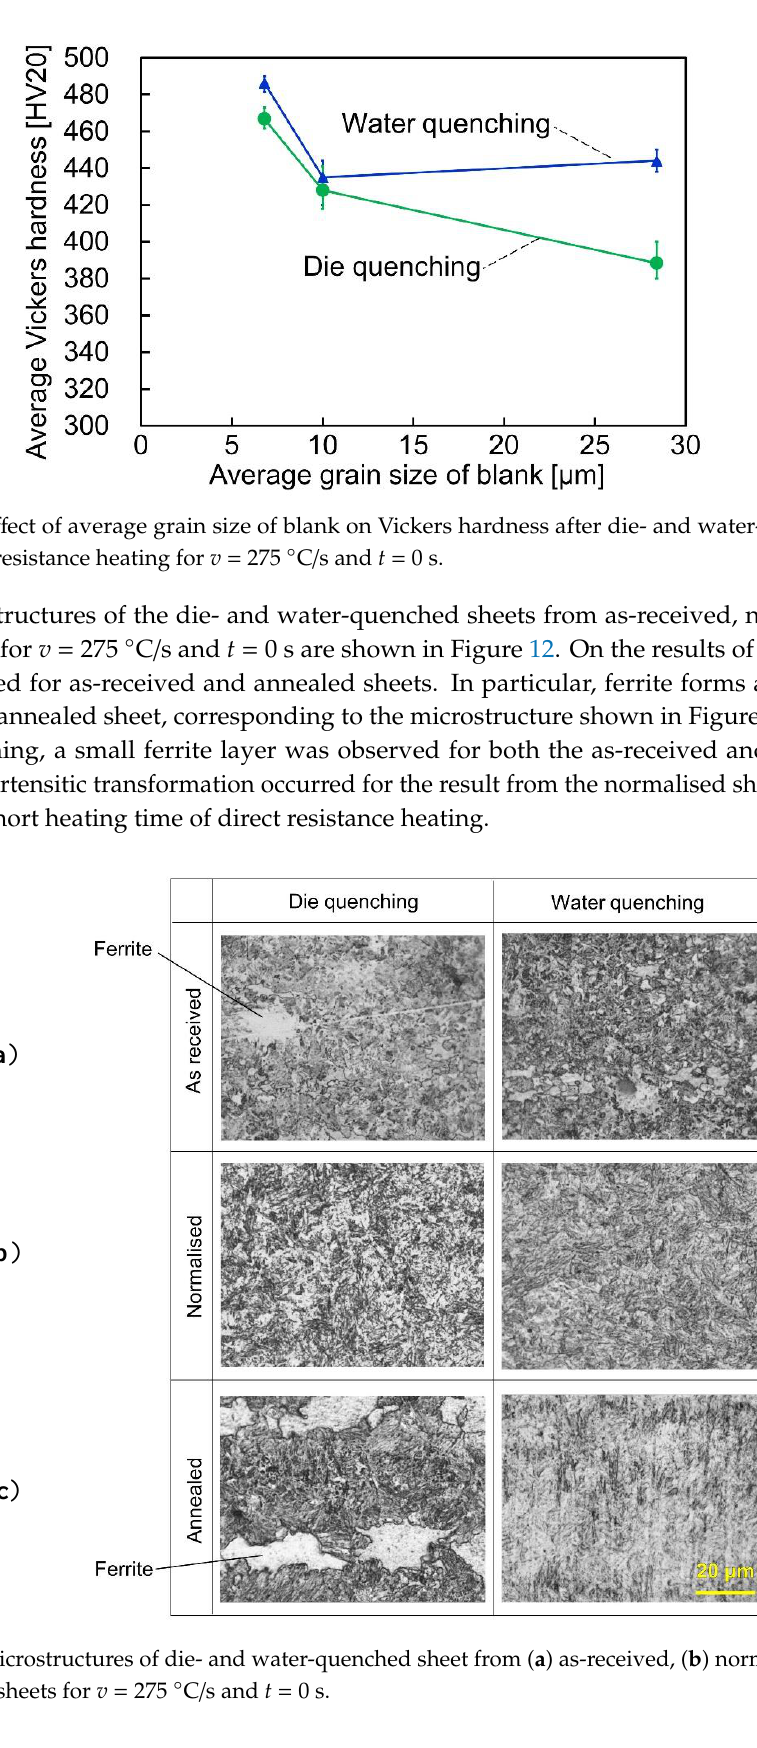
Figure 10. Effect of heat treatment of blank on distributions of Vickers hardness after die-quenching using direct resistance heating for v = 275 °C/s and t = 0 s.